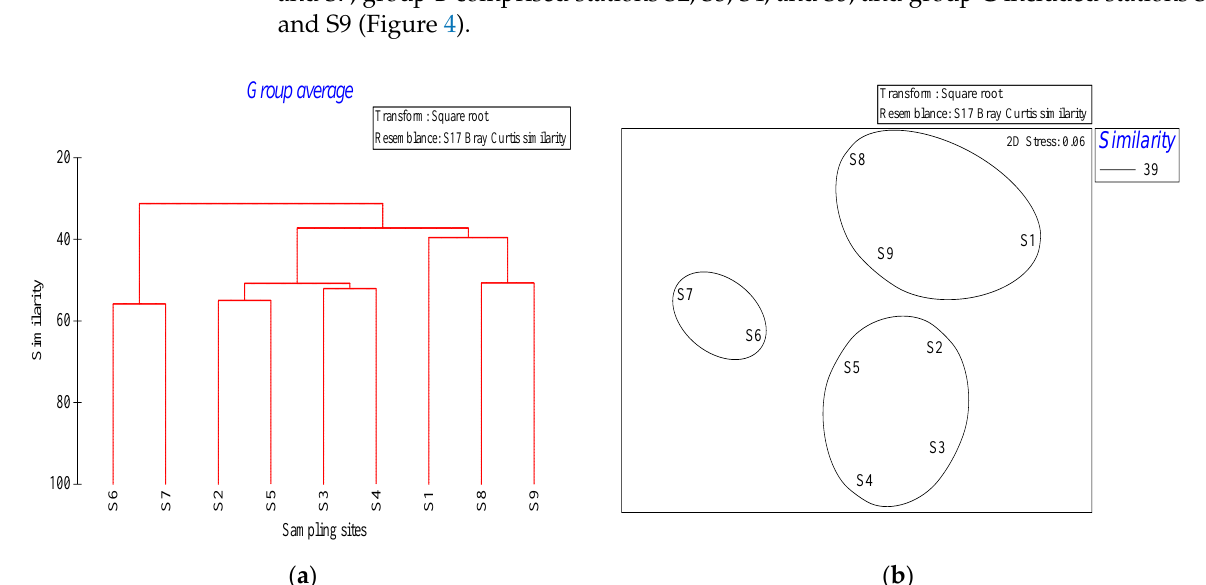
Figure 5. Cluster and NMDS analysis of phytoplankton structure in the waters around Macau examined in December 2019. ( a ) Cluster analysis of Bray-Curtis similarity indices of different sampling sites. ( b ) NMDS based on the Bray-Curtis similarity ordination (2D stress = 0.06). Ellipses around the clusters indicate the standard deviation of point scores based on sample-group clusters.